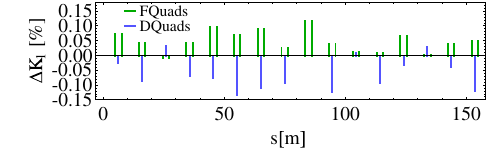
FIG. 2. Relative errors (percent) of triplet quadrupole magnet strengths in Ring 2, determined by LOCO analysis.